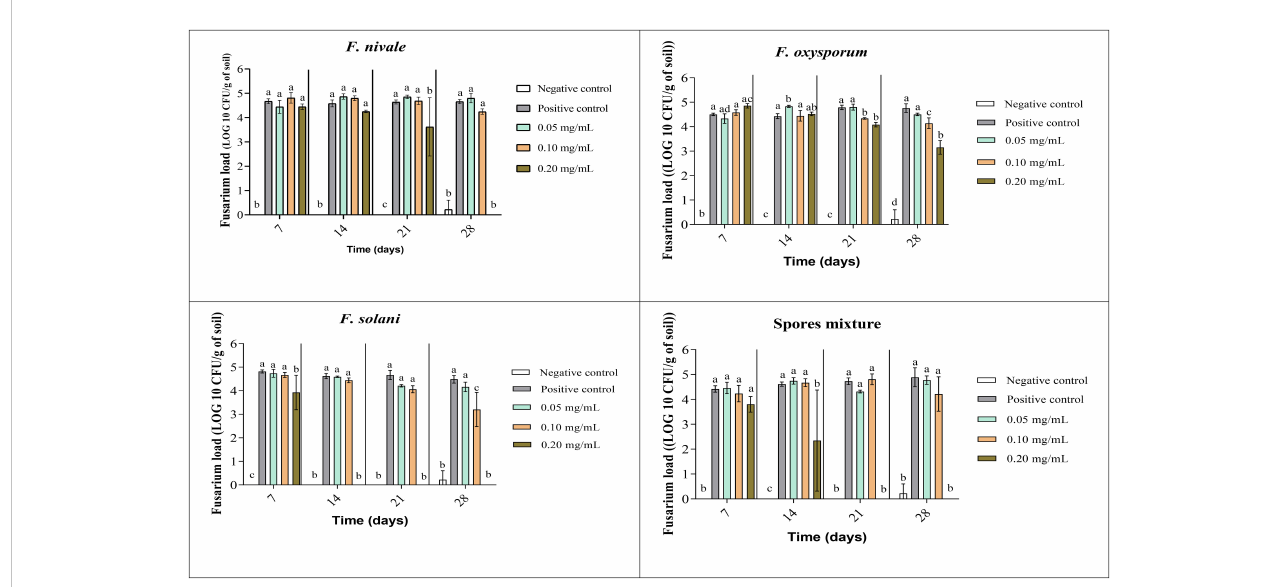
FIGURE 8 Fusarium load during treatment of ryegrass pots with carvacrol for four weeks in disinfested soil under greenhouse. Means (± SD, n = 3) denoted by the same letter indicate no signi fi cant difference according to Tukey ’ s multiple range tests at p< 0.05.